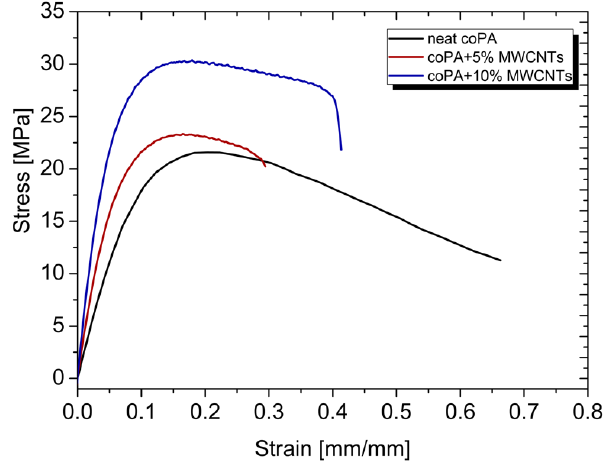
Figure 8. Representative stress-strain curves of coPA and its masterbatches containing 5 wt% and 10 wt% MWCNT. 10 wt% MWCNT. Table 3. Mechanical properties of neat coPA and coPA/MWCNTs composites.